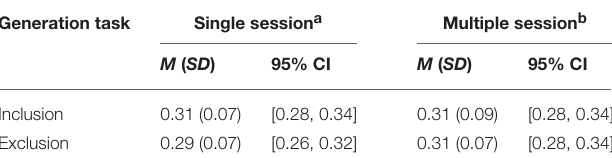
TABLE 8 | Proportion of generated pattern type trials in single and multiple session conditions.